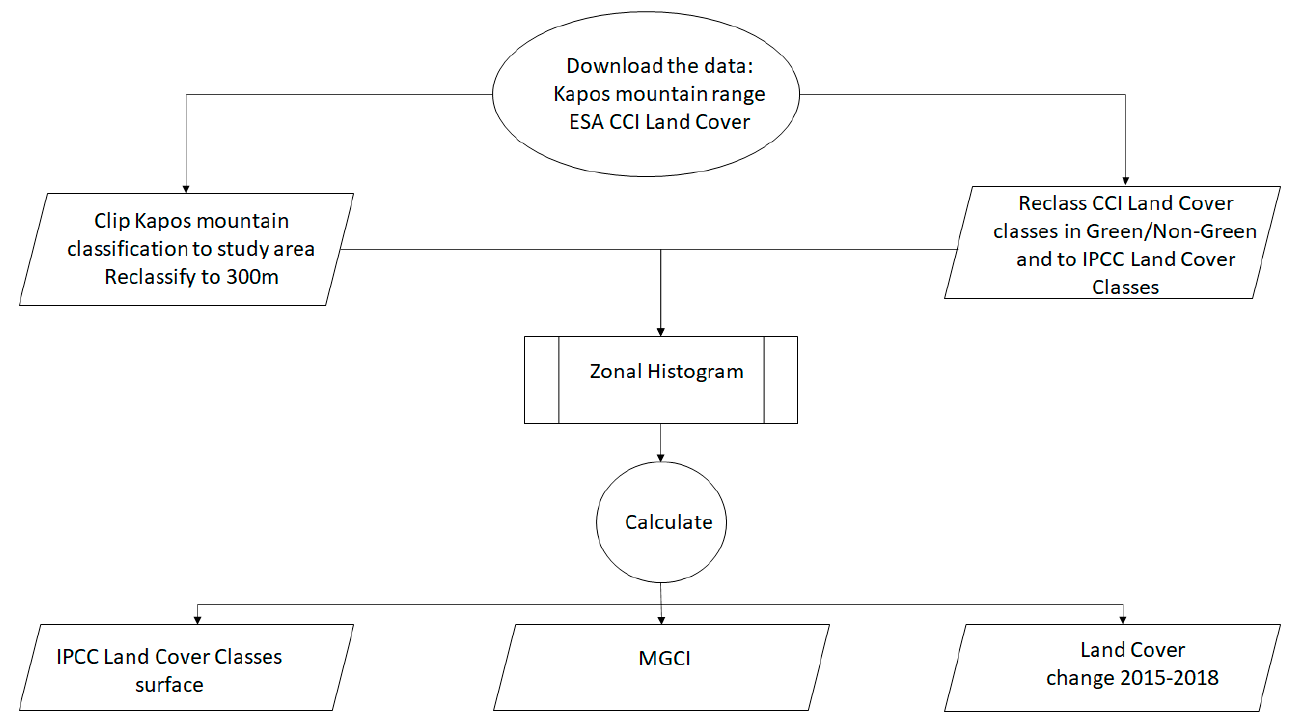
Figure 1. Workflow to calculate MGCI from EO products.